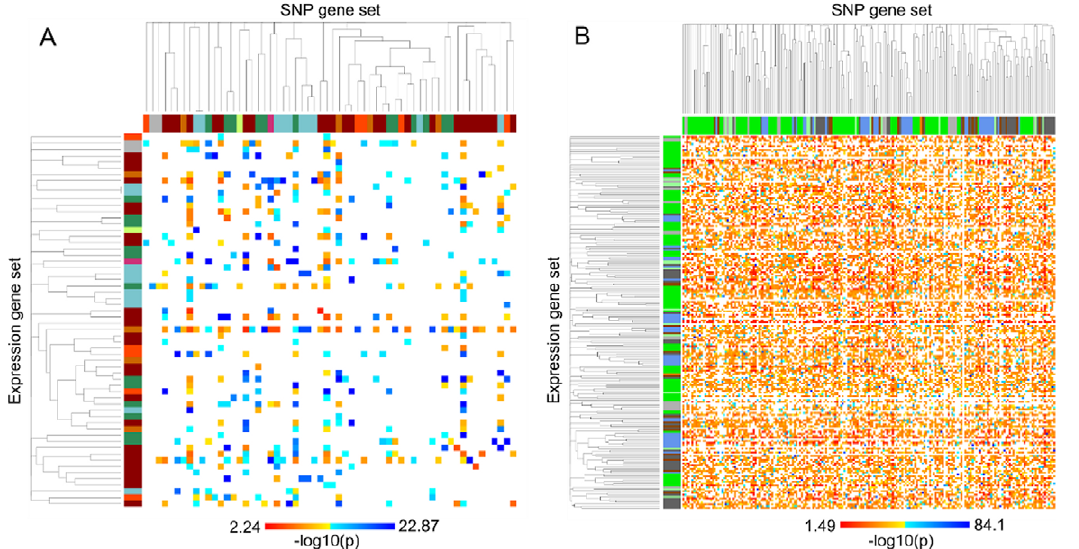
Figure 2. Heatmaps with points indicating associations (FDR , 5%) between SNP (x-axis) and expression (y-axis) GSs. SNP and expression GSs are indexed based on hierarchical clustering using distances between GSs (distance determined by average proportion of genes shared between GSs). The color of the points indicate the level of association significance (blue = less significant, red = more significant) doi:10.1371/journal.pone.0043301.g002 PLOS ONE |